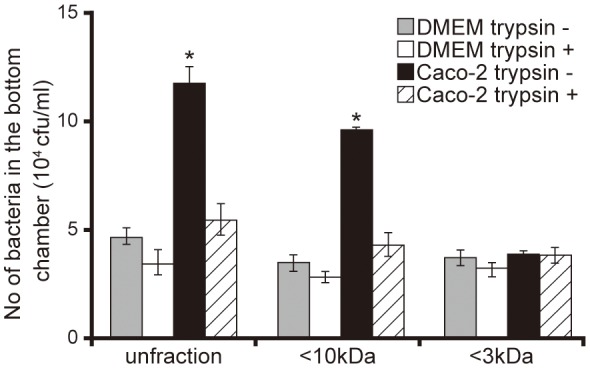
Characterization of Caco-2 cell supernatant facilitating penetration of P. aeruginosa PAO1 strain through the mucin layer. A 15-day Caco-2 cell supernatant and Dulbecco's modified Eagle medium (DMEM; control) were filtered through 10- or 3-kDa MW cut-off membranes and treated with or without a trypsin (trypsin + or −). The filtered and unfiltered samples with or without trypsin filled the bottom chambers of Transwell. The P. aeruginosa PAO1 strain was added to the top chambers, and after 3 h, the numbers of bacteria in the bottom chambers were counted. Error bars indicate standard error (n = 3). *P < 0.05 compared with DMEM of the same fraction size.